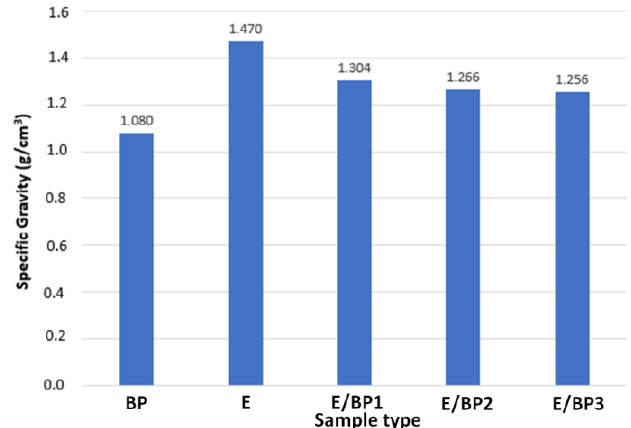
Fig. 5. The plot of specific gravity of the various brake pad specimens